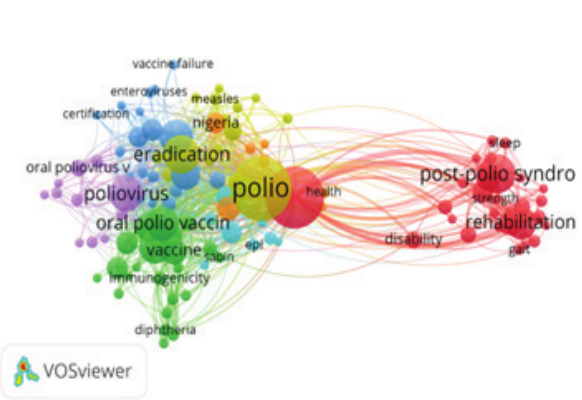
Figure-V: Co-occurrence author keywords network visualizations